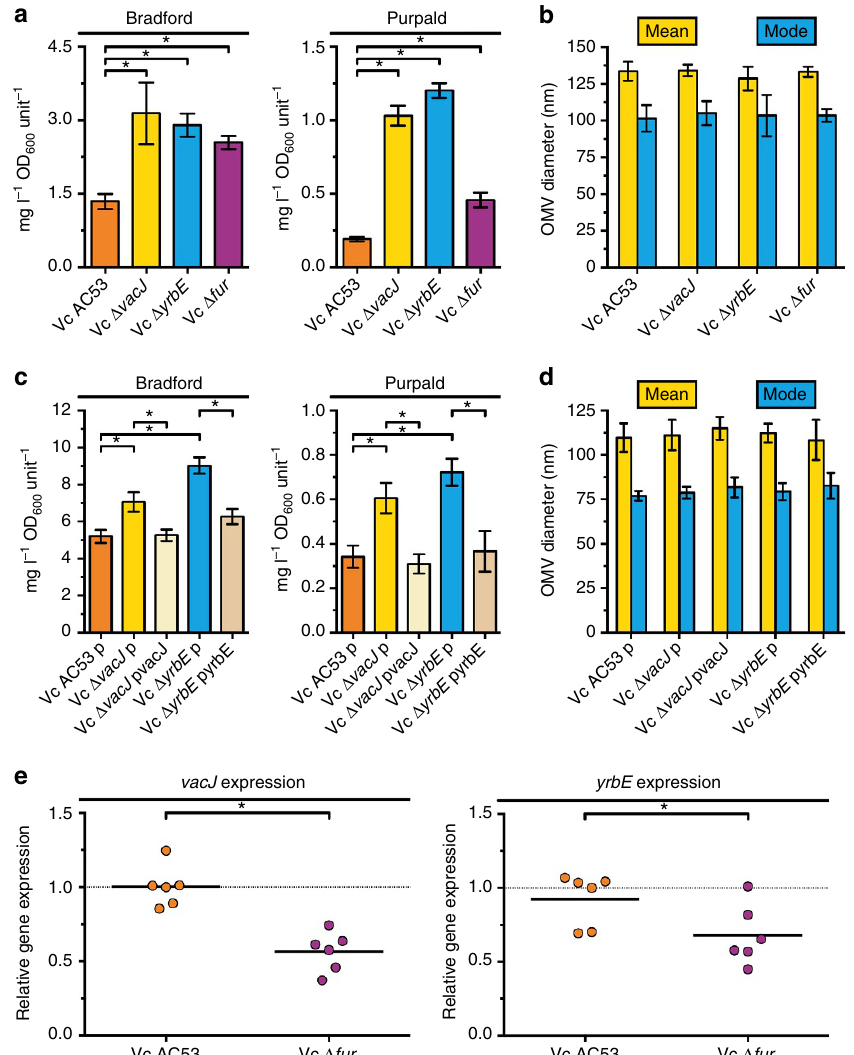
Figure 3 | Excessive OMV production by PL transporter mutants, and regulation of vacJ and yrbE expression in V. cholerae . ( a , c ) OMV preparations derived from equivalent OD 600 units of cultured wild-type (Vc AC53) and deletion mutants (Vc D vacJ , Vc D yrbE and Vc D fur ) as well as wild-type containing vector control (Vc Ac53 p) and deletion mutants containing either vector control (Vc D vacJ p, Vc D yrbE p) or expression plasmids (Vc D vacJ pvacJ and Vc D yrbE pyrbE) were analysed for total protein (Bradford) and lipopolysaccharide (Purpald). Mean values with s.e.m. are shown ( n ¼ 12 biological replicates for Vc AC53 and n ¼ 6 biological replicates for all other strains). ( b , d ) Distributions of OMV sizes produced by the strains were determined by nanoparticle tracking analysis. Mean values with s.d. of mean and mode OMVdiameter sizes within respective OMVpreparations are shown ( n ¼ 12 biological replicates for Vc AC53 and n ¼ 6 biological replicates for all other strains). ( e ) Relative expressions of vacJ and yrbE in Vc AC53 and Vc D fur were determined by qRT-PCR. Horizontal bars highlight the mean of each data set ( n ¼ 6 biological replicates). Dotted lines indicate a relative gene expression of 1. ( a , c , e ) Significant differences between the data sets are marked by asterisks ( P o 0.05; one-way ANOVA followed by Sidak’s multiple comparison post test ( a , c ) or unpaired t test ( e